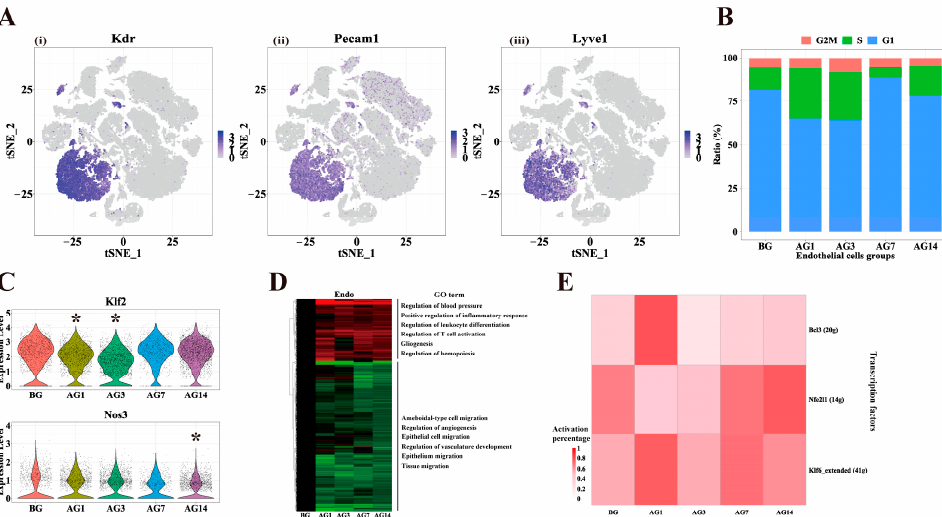
Figure 5. Aberrant gene expression and aberrant activity transcription factors in endothelial cells. ( A ) Gene expression of endothelial cells markers, (i) Kdr , (ii) Pecam1 and (iii) lyvel . Color bars indicate